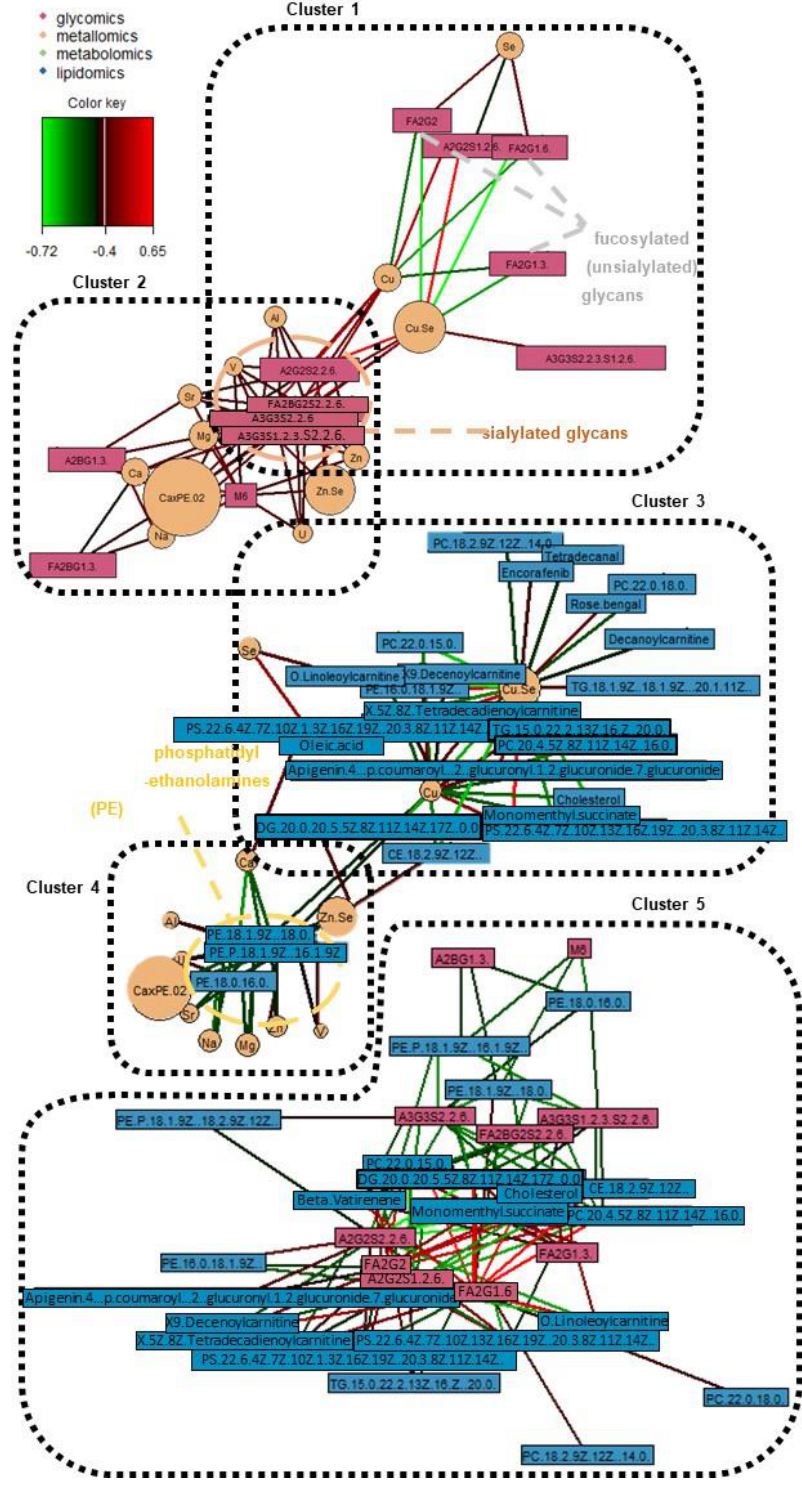
Figure 5. Relevance networks of significant omics features across various bi-omics combinations (all r ≥ 0.4; p -value < 0.05). The color key indicates the correlation coefficient values annotated by the connection lines between variables. Red colored connection lines denote positive correlations, while green colored connection lines denote negative correlations between variables. The intensity of the colors is scaled according to the magnitude of the correlation coefficient